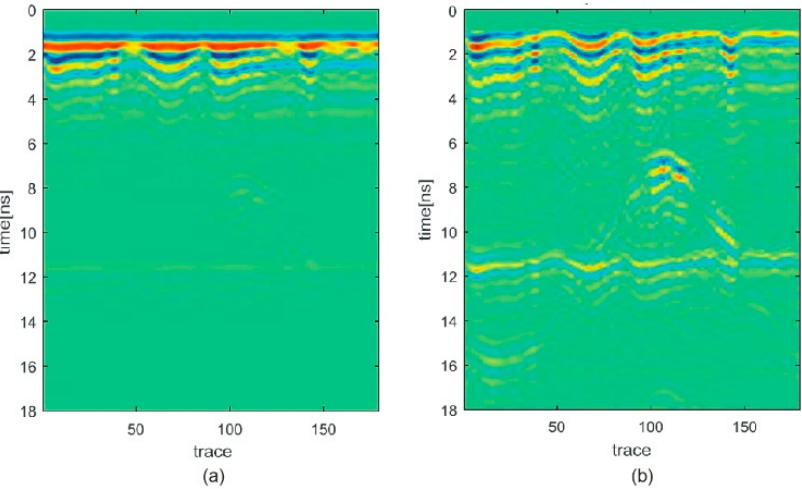
Figure 6. Radargrams of the simulations for the softwood tree scenario. ( a ) Raw radargam; ( b ) processed radargram after the application of the pre-processing stage.